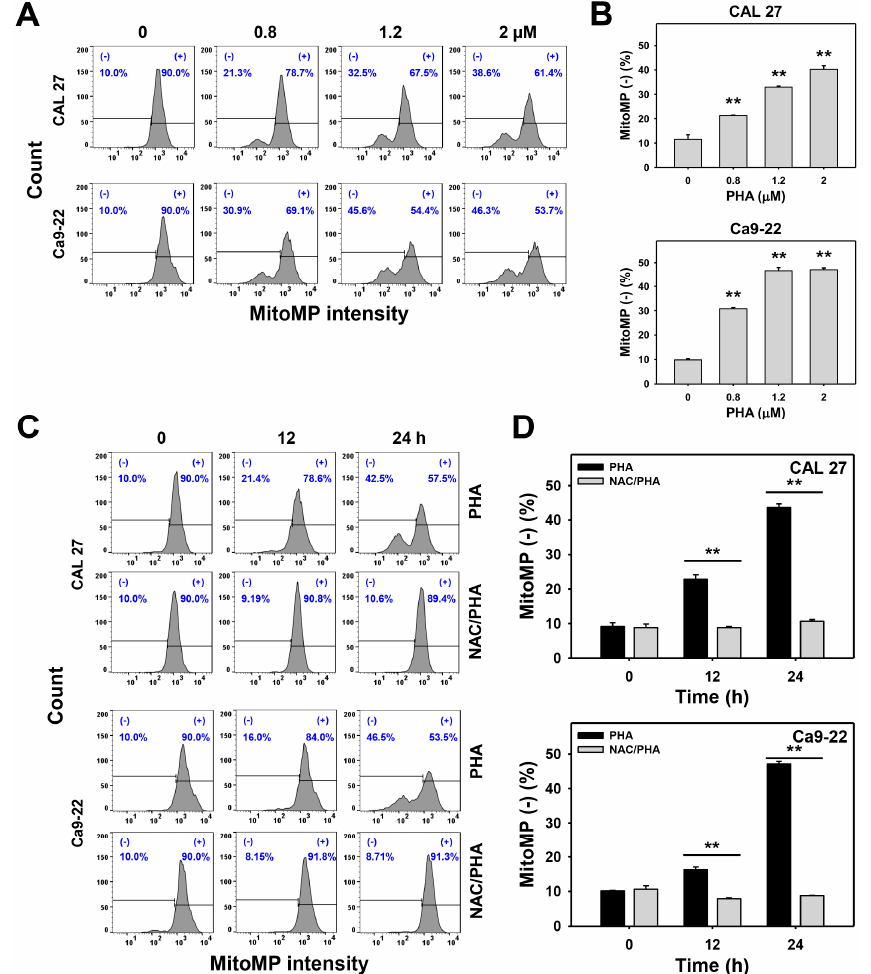
Figure 7. PHA enhances the MitoMP intensity in oral cancer cells. ( A , B ) MitoMP analysis. Cells were exposed to 0 (0.1% DMSO medium as a control), 0.8, 1.2, and 2 μ M PHA for 24 h. ( − ) population was counted for MitoMP ( − ) (%). ( C , D ) Suppression of PHA-induced MitoMP depletion by NAC. To evaluate the recovery effect of NAC, NAC (10 mM for 1 h) was added to cells before 24 h treatment with PHA (control (0.1% DMSO medium) and 2 μ M), i.e., NAC/PHA. Data, means ± SDs ( n = 3 independent experiments); ** indicates p < 0.001. The positive control for MitoMP depletion is provided in the Supplementary Figure